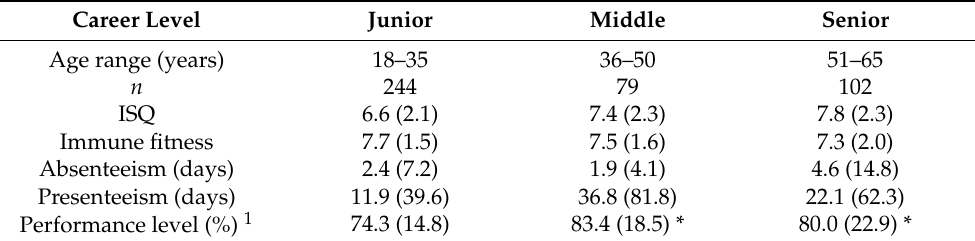
Table 4. Absenteeism, presenteeism, and work performance on days with reduced immune fitness according to career level.